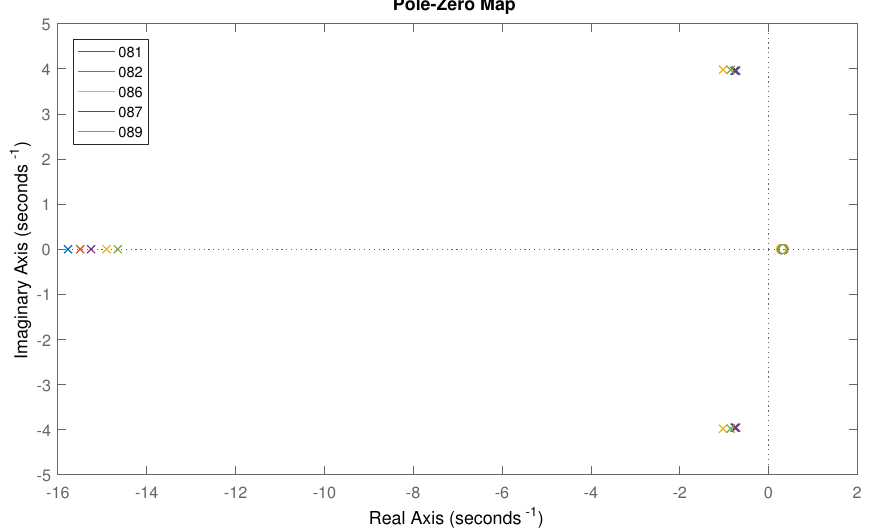
Figure 19. Pole-zero maps of the intrinsic admittance Y i from different experiments (experiments: 081, 082, 086, 087 and